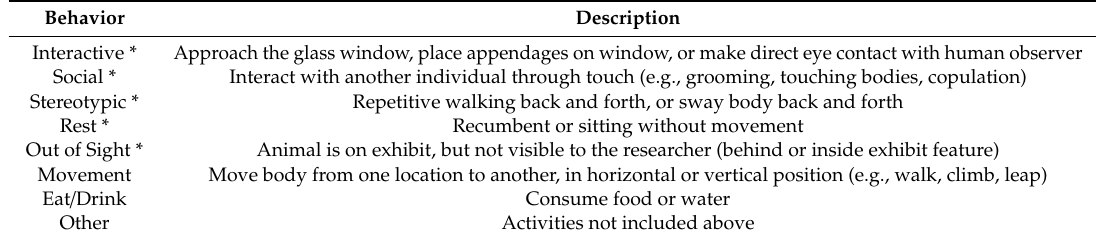
Table A4. Tamandua and galago ethogram, with behaviors of focus indicated with an asterisk